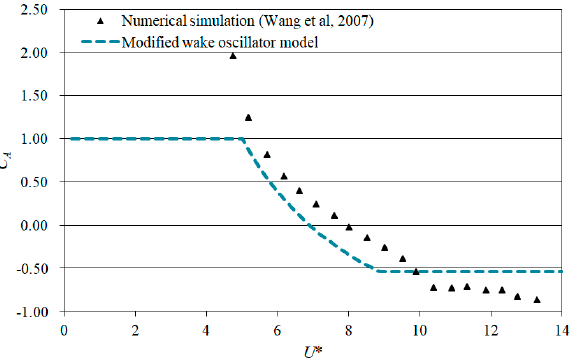
Figure 7. Variation of C A in the modified wake oscillator model versus reduced velocity ( m * = 1.66) [34].